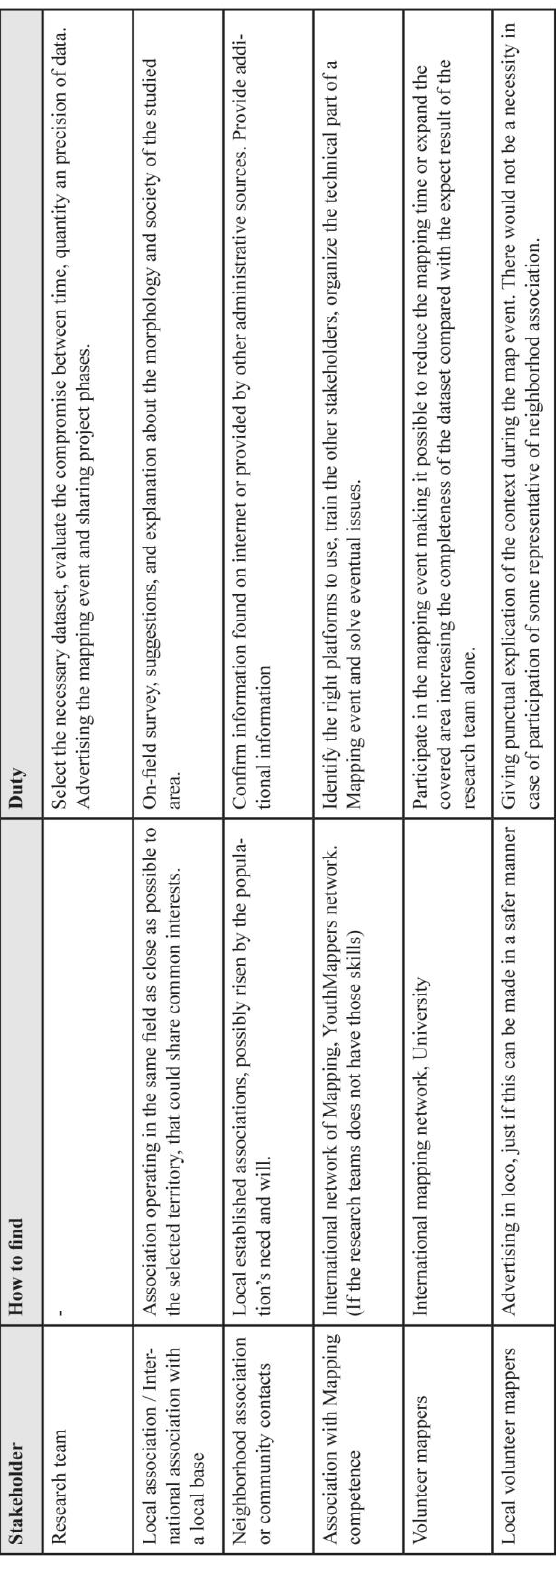
Table 2. Success of methodology